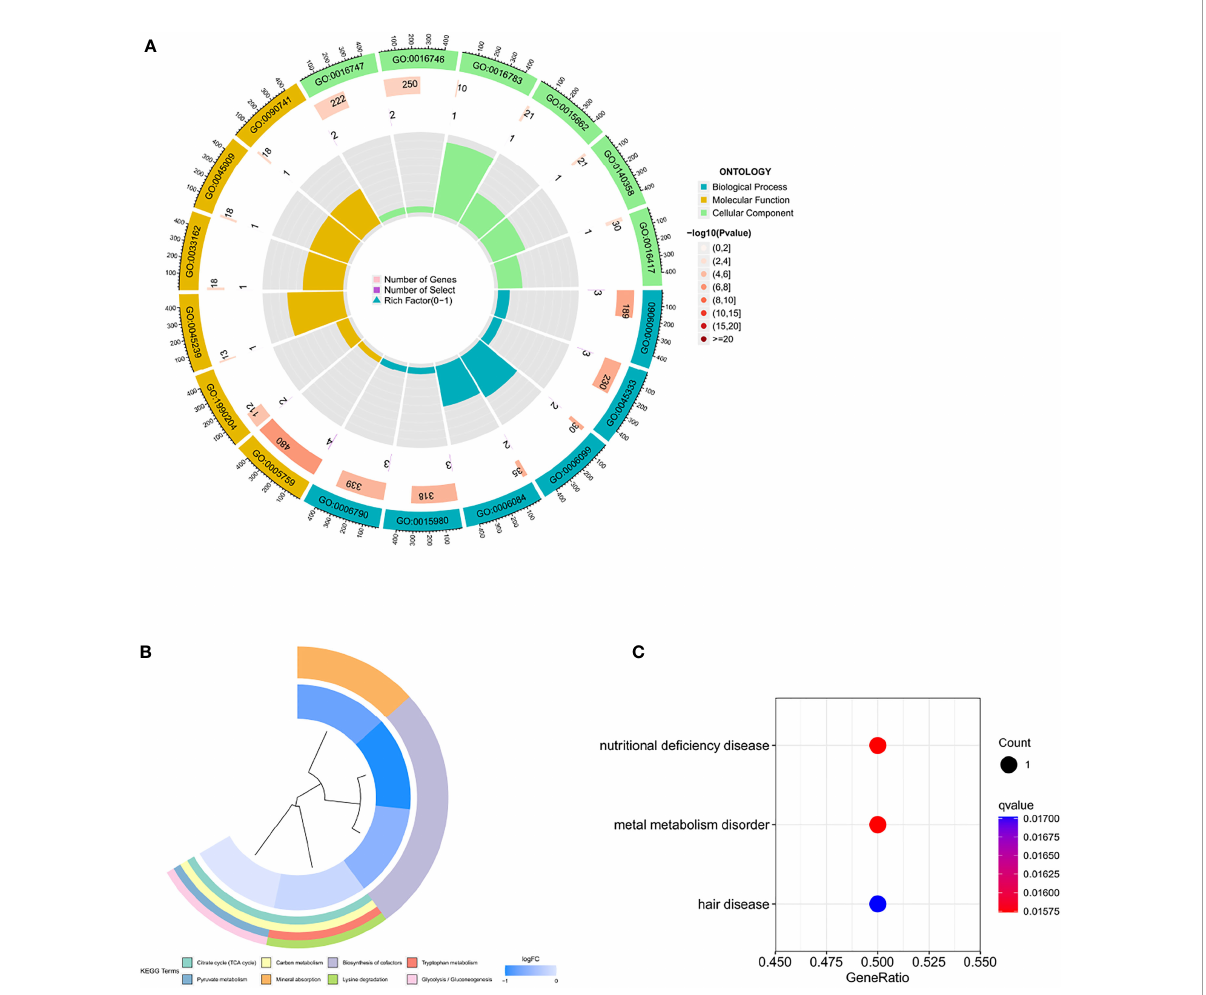
FIGURE 2 Enrichment of fi ve prognosis-related CRGs (A) Gene ontology enrichment (B) KEGG metabolic pathway Enrichment (C) Disease